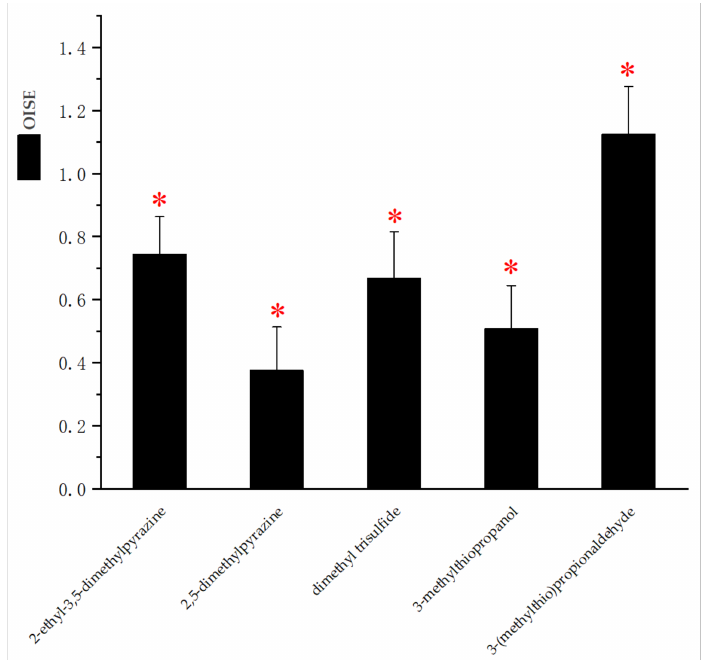
Figure 1. Mean value of odor-induced saltiness enhancement (OISE) in 0.3% NaCl solution with an odorant. Red stars indicated that the mean saltiness intensity was significantly higher than the reference (0.3% NaCl solution): * p < 0.05. Error bars represented the standard errors of the